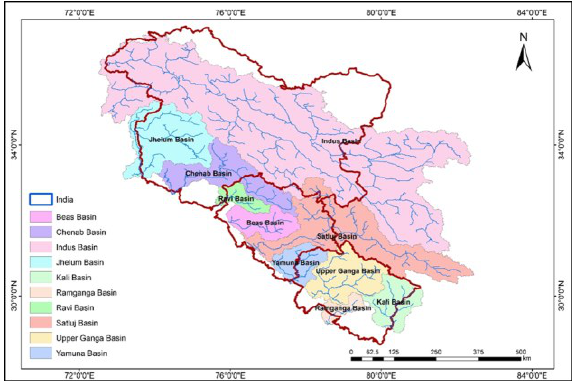
Figure 1. NWH region with state and river basin boundaries.